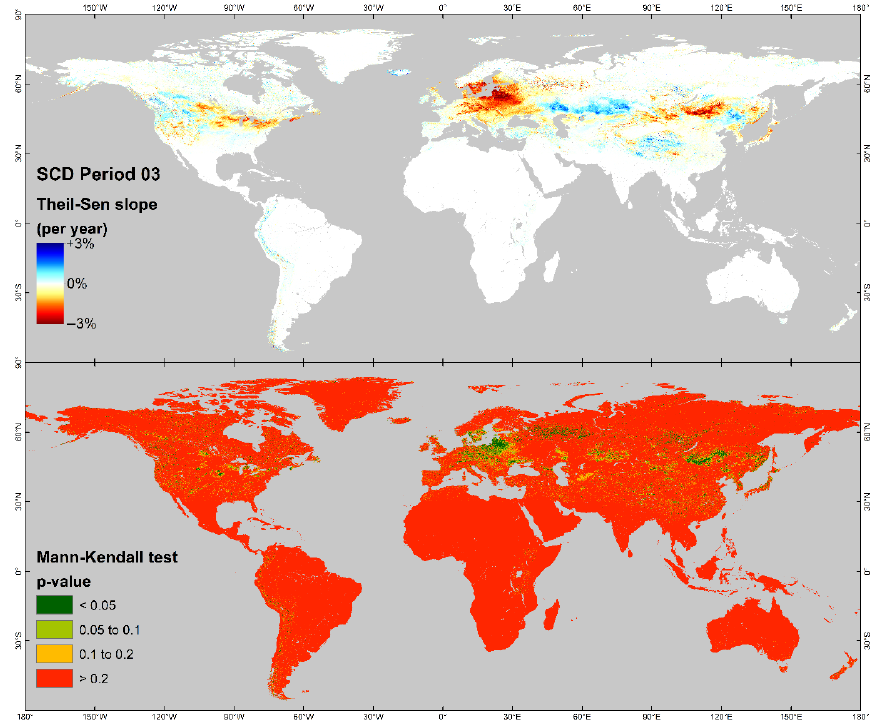
Figure 6. Pixel-based development of SCD in March. The Theil–Sen slope is shown above and the associated p -values are shown below. The decrease in the SCD in the Baltic Sea region is particularly striking, and there are